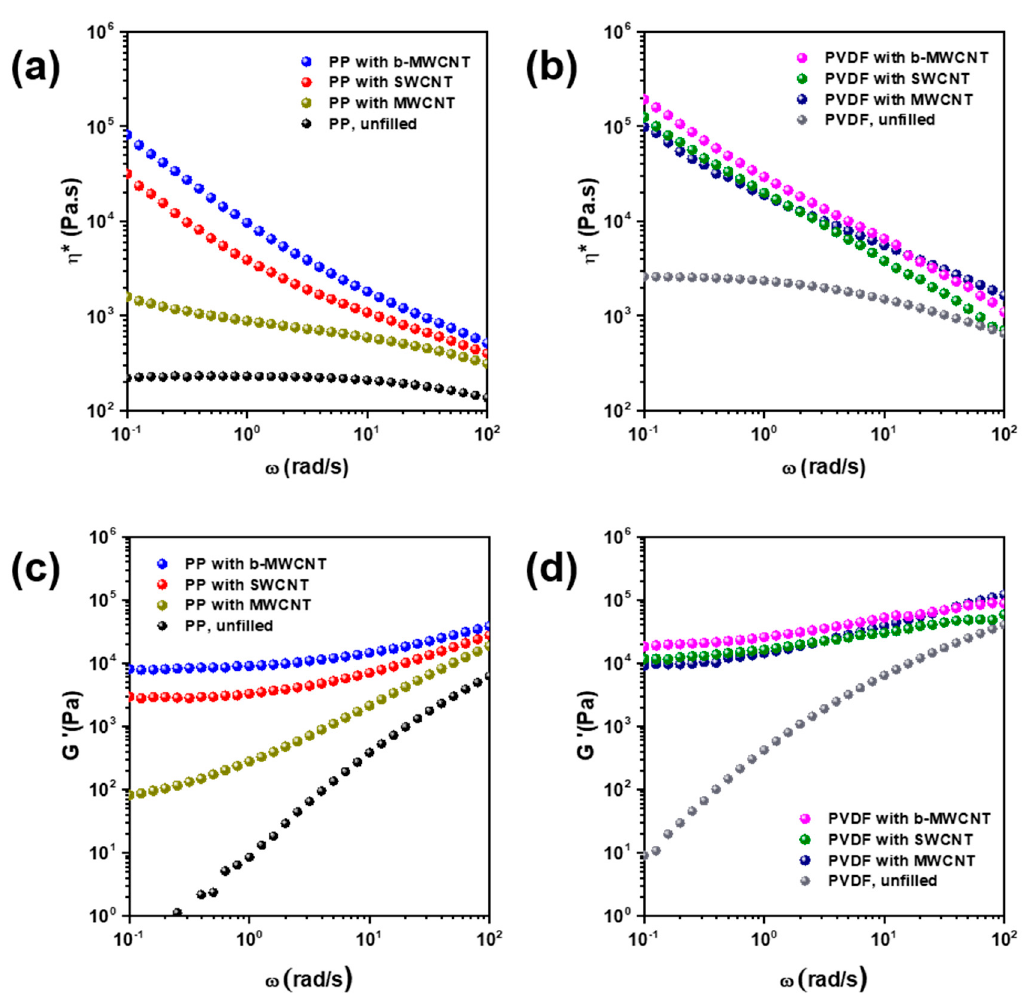
Figure 5. ( a , b ) complex viscosity I η *I of PP and PVDF based composites, ( c , d ) storage modulus G ′ of PP and PVDF based composites. All composites contain 2 wt % CNTs.